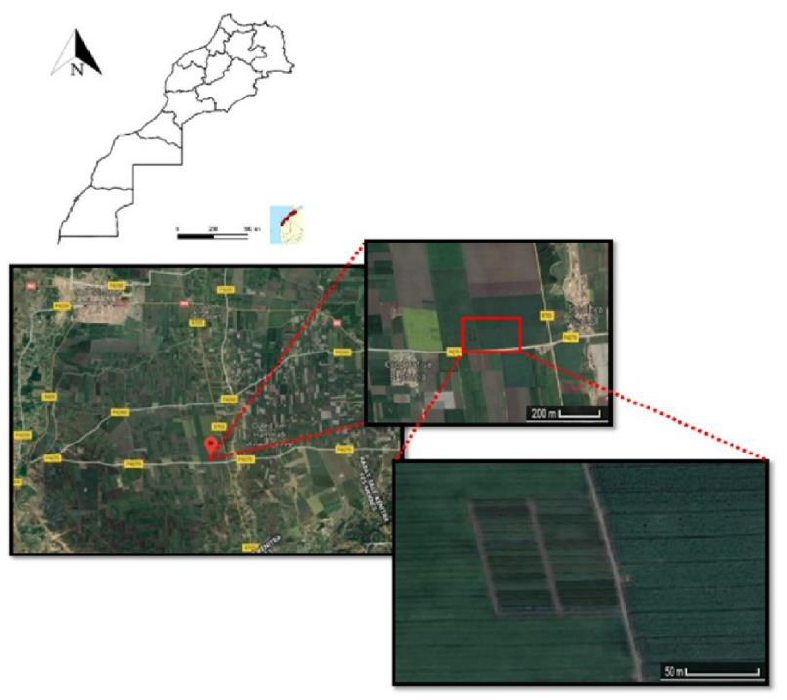
Figure 2. Field site of the experimental platform 07 of domain HAMMA (Google Maps, 2019).